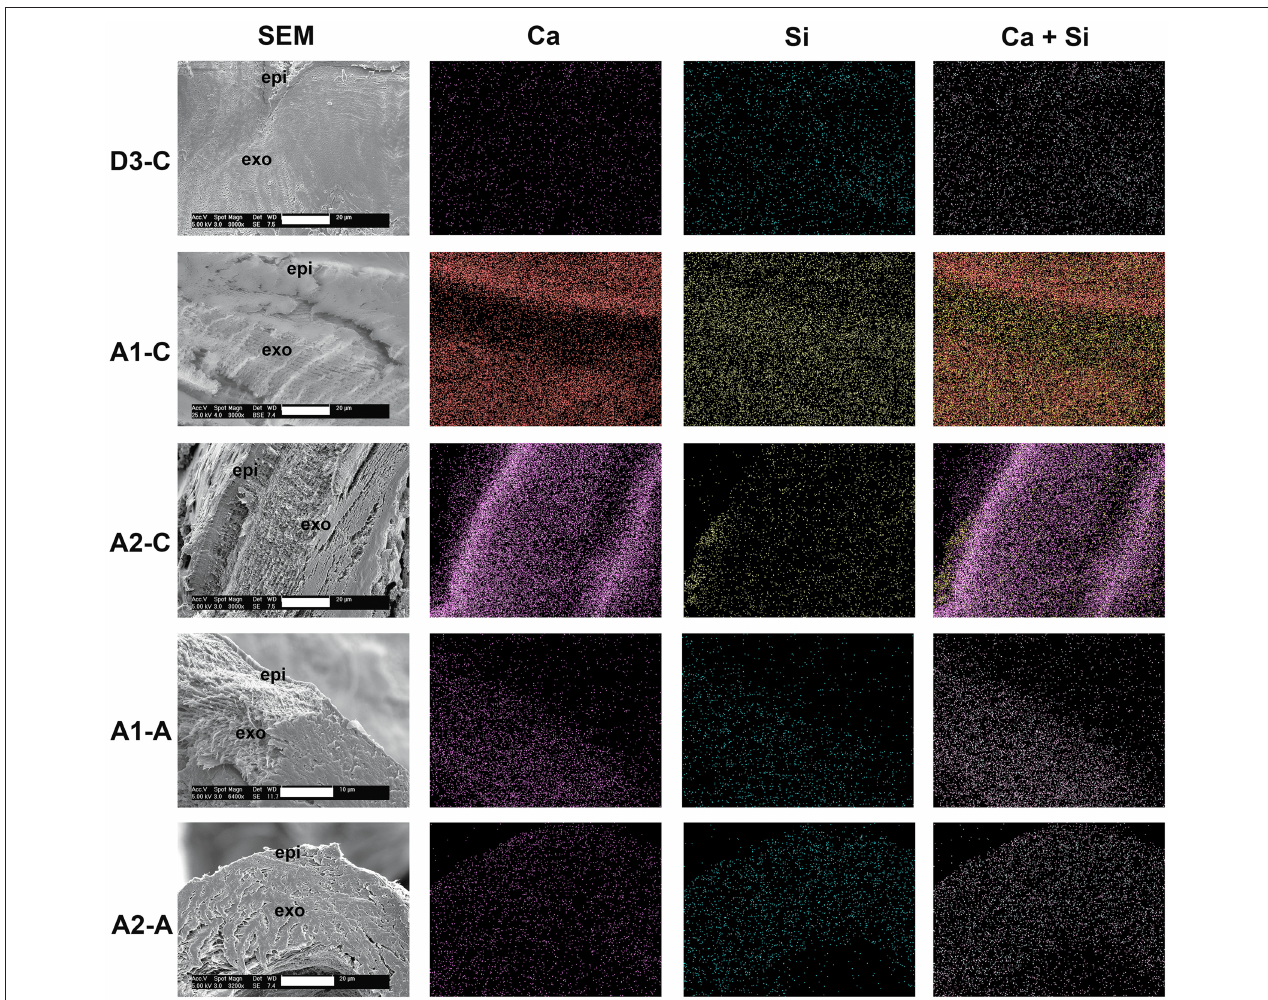
FIGURE 1 | SEM images and corresponding EDAX maps of the elemental distributions of Ca, Si and a composite of the Ca and Si (Ca + Si) within the carapace [C] and arthrodial membrane [A]. The labels on the left specify the molt stage followed by the tissue type. Thus D3-C refers to stage D3 carapace while A1-A is stage A1 arthrodial membrane. Orientation is indicated in the SEM images by the location of the epicuticle [epi] and exocuticle [exo]. Maps revealed that silicon levels were approximately equal to those of calcium in carapace prior to the onset of mineralization (stage D3). The proportional contribution of the Si signal decreased as that of calcium increased as mineralization began (stages A1 and A2). Silicon and calcium were present in low amounts in non-mineralizing arthrodial membrane at both stage A1 and A2. Scale bars (white) on each SEM image are 20 µ m, except for A1-A which is 10 µ